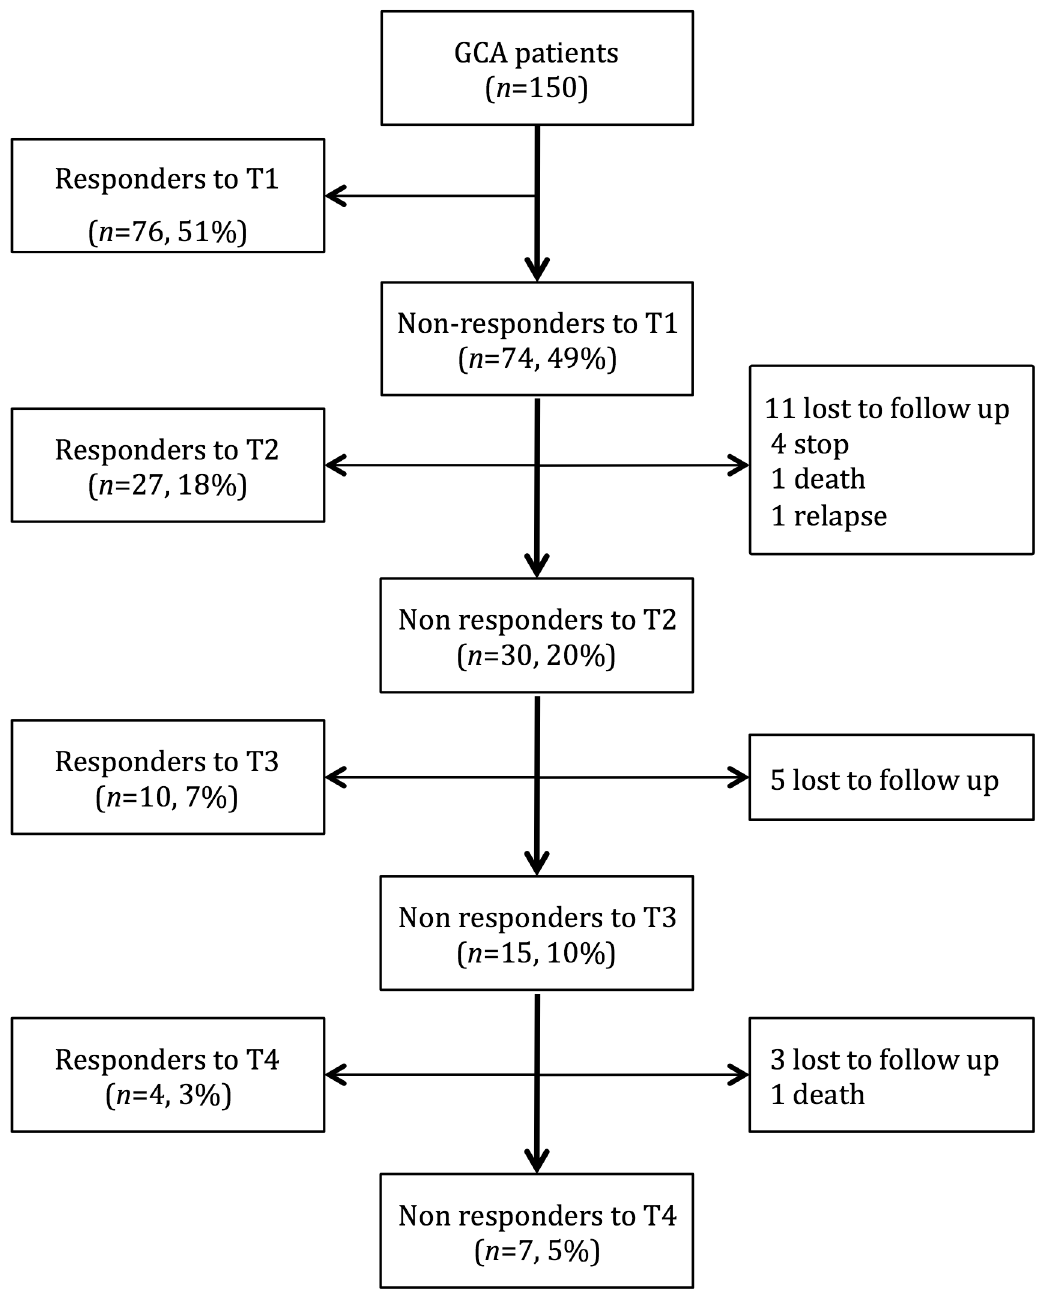
Figure 1. Flow chart of the study population. GCA: giant cell arteritis, T1 to T4: ACTH tests 1–4.